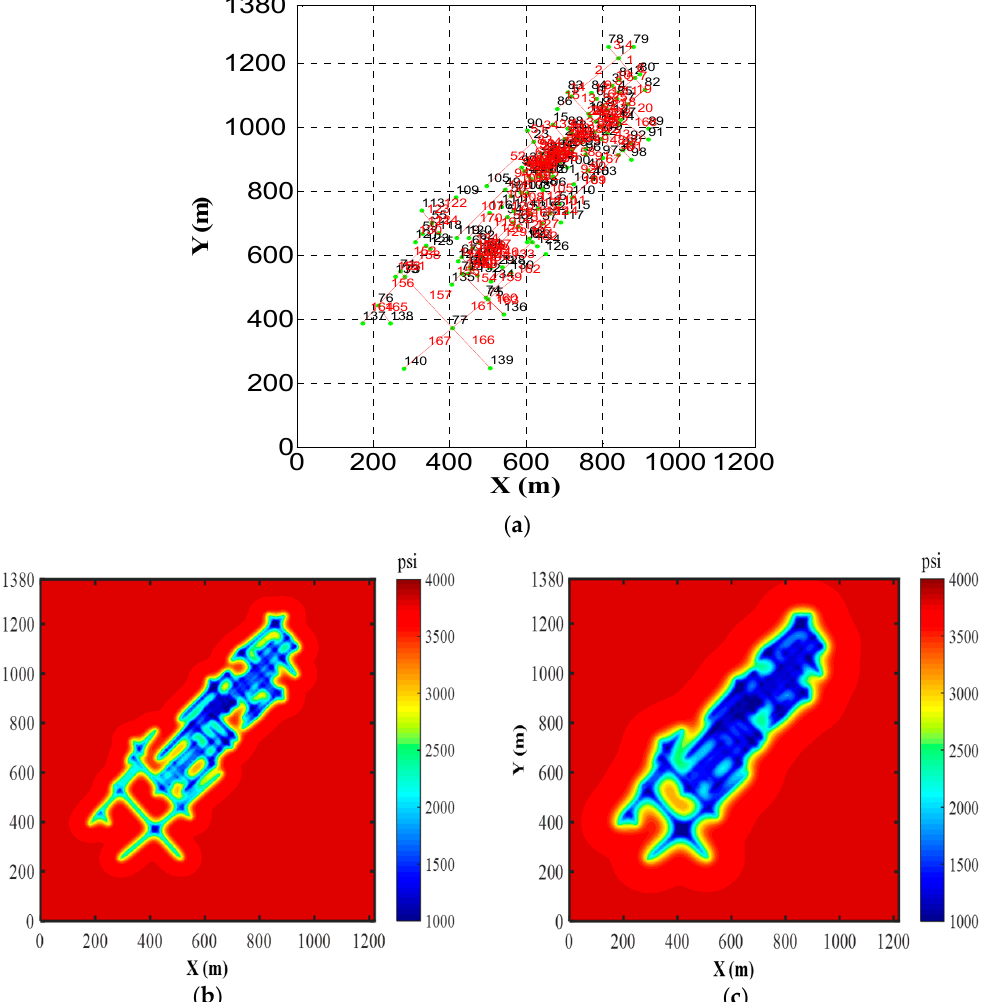
Figure 4. Shale gas model with fractures in Barnett shale with one vertical well in Case 1: ( a ) Detection results of the nodes and lines with the proposed method; ( b ) the pressure profile after 3 years production; ( c ) the pressure profile after 10 years production.